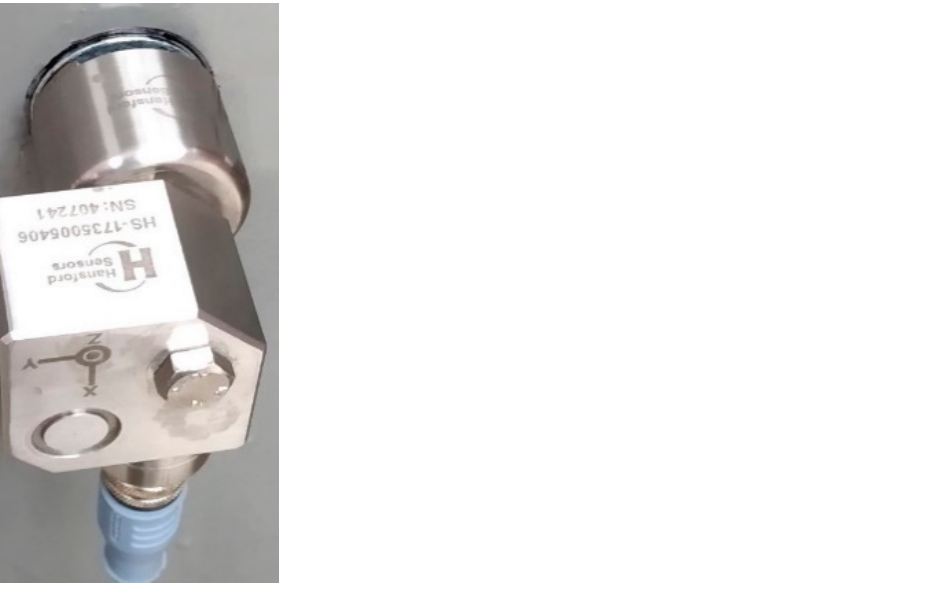
Figure 2. The Hansford Sensors piezoelectric accelerometer (model 1735005406) which was used during the measurements.